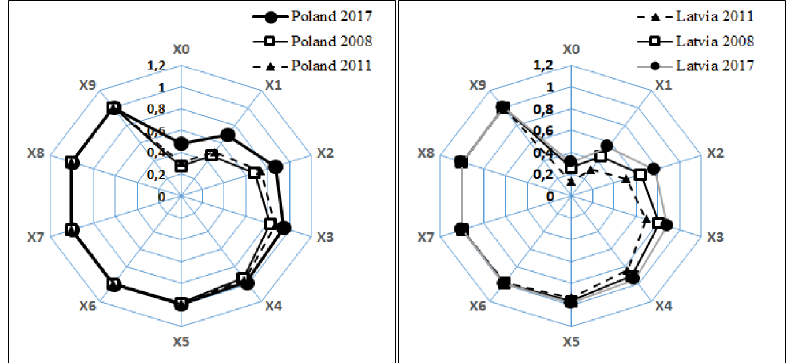
Figure 6. Presentation of the level of material deprivation in 2008, 2011 and 2017. Source: own study based on EUROSTAT.